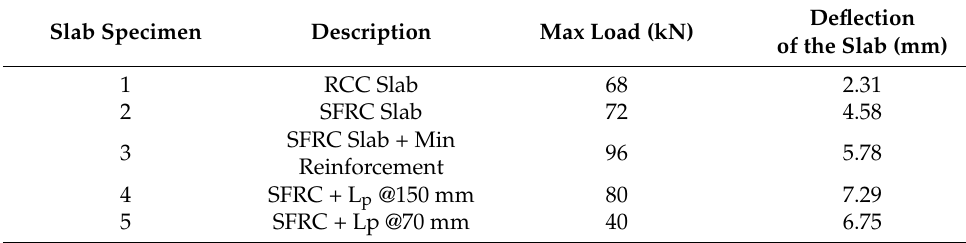
Table 7. Test load deflection of the slab under cyclic